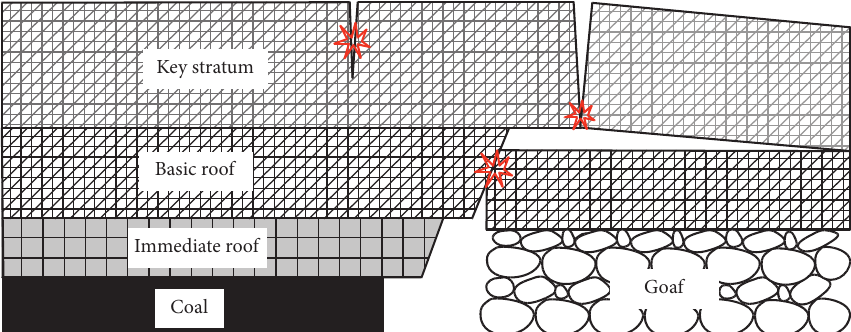
Figure 6: Sketch of dynamic load produced by roof